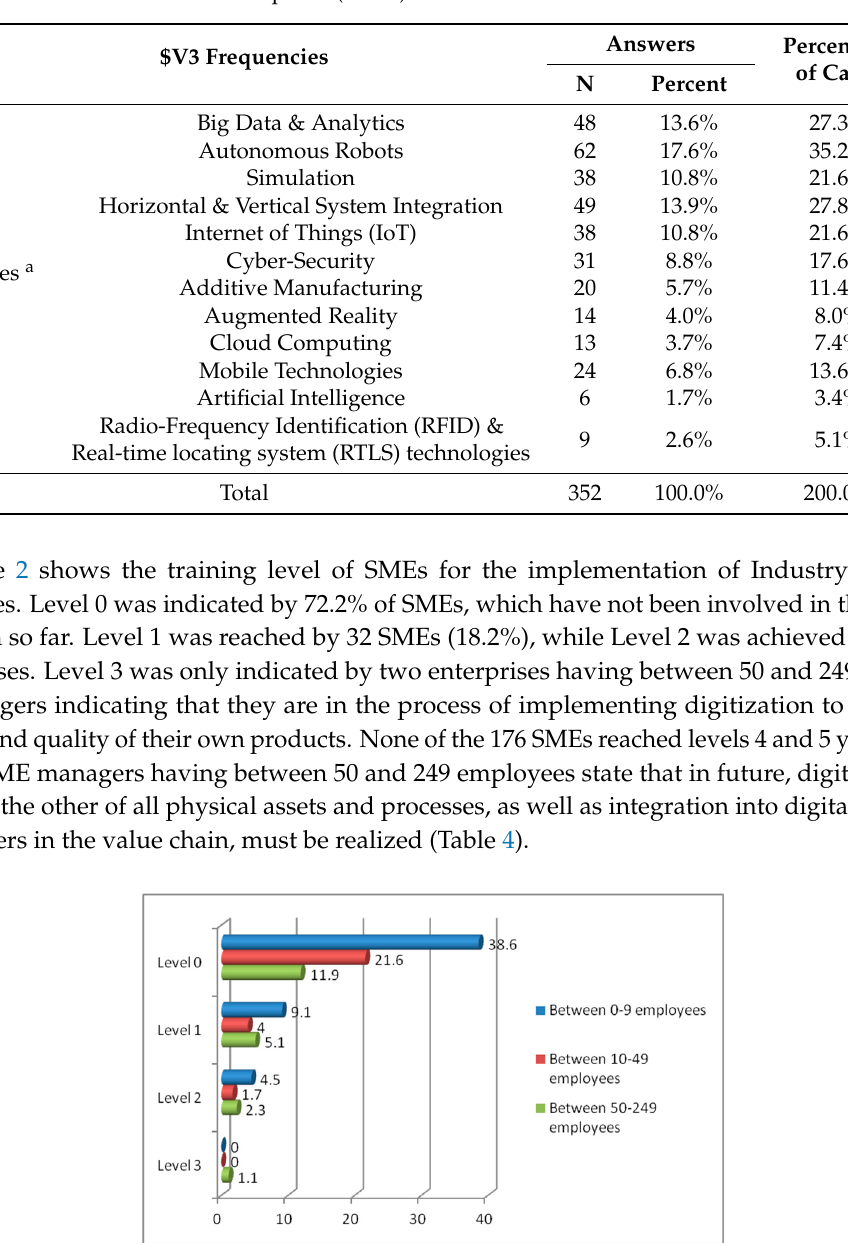
Table 4. The contingency table regarding the training level of SMEs in relation to the size of enterprises.